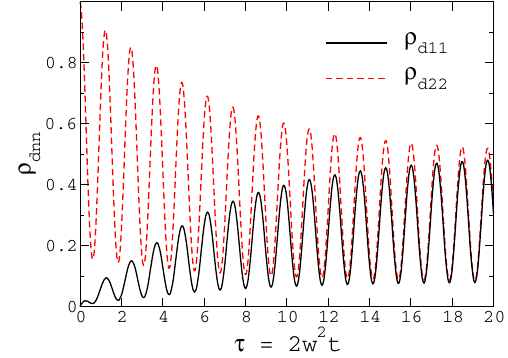
Fig. 7 Thetimedependenceof ρ d 22 and ρ d 11 when β = π/ 6, ¯ ω B = 10 and μ ν B /ω ν = 5. In the initial moment of time ρ d 22 ( 0 ) = 1 and all other elements of the density matrix ˆ (cid:13)( 0 ) in the flavor representation are